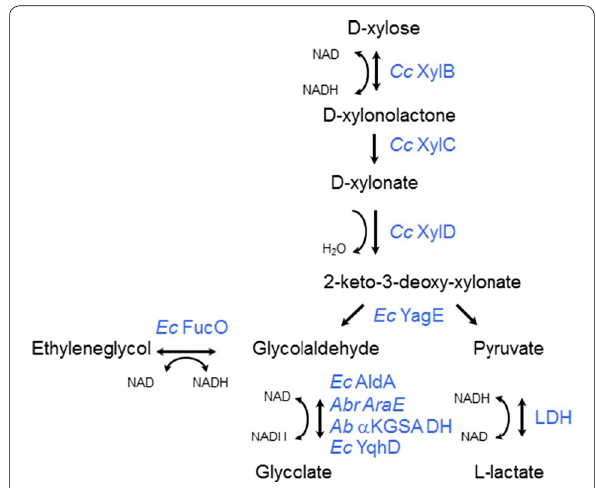
Fig. 1 Oxidative d -xylose pathway enzymes including the additional enzymatic steps to produce glycolic acid, ethylene glycol or lactic acid. The enzyme abbreviations are summarized in Table